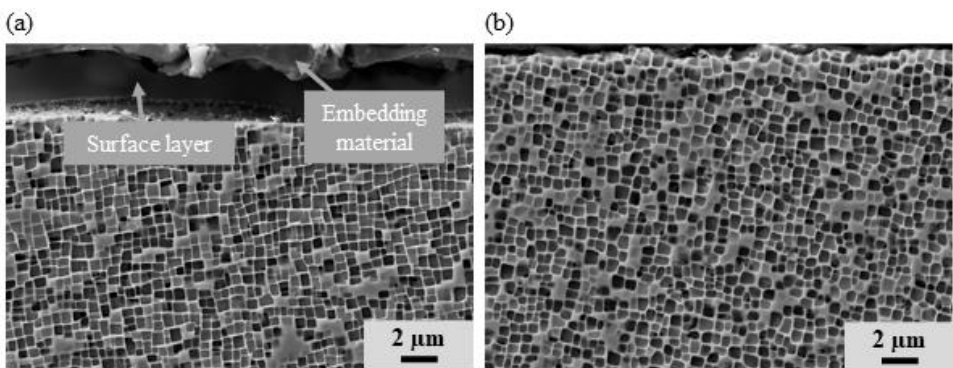
Figure 2. Microstructure in the near-surface area after heat treatment under vacuum of thin-cast specimens ( a ) with surface layer, ( b ) surface layer removed by grinding with SiC paper with grits of 1000.